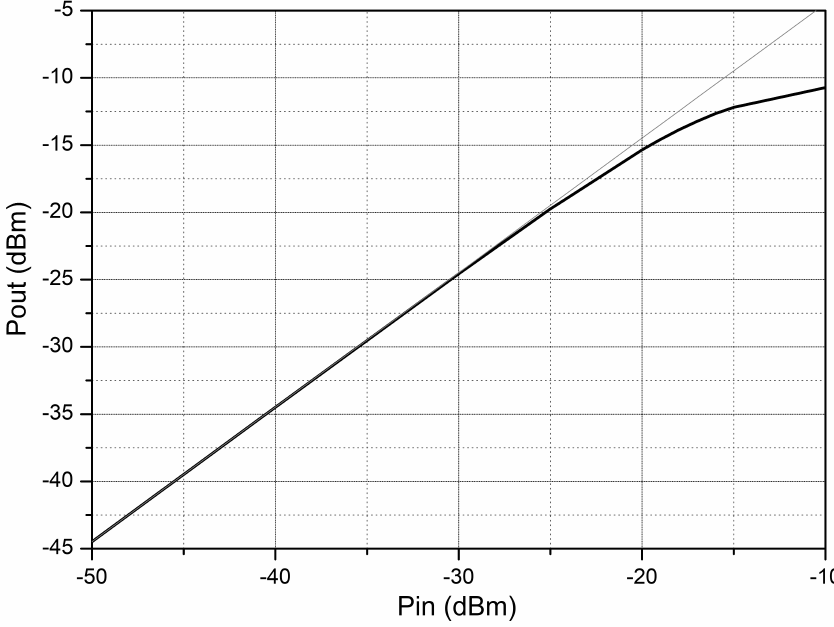
Figure 13. Measurement of the input 1-dB compression point for I 01 = 600 µ A and I 02 = 50 µ